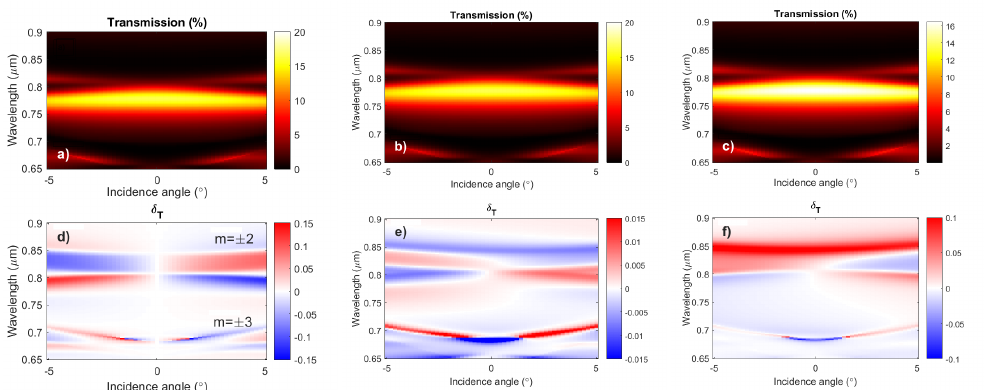
Figure 3. Angular and wavelength-resolved transmission ( a – c ) δ T ( d – f ) spectra of the addressed nanostructure with the uniform spatial distribution of the magnetization in the ferrimagnetic layer (left column), magnetization modulation with λ SW = P (center column), and 2 λ SW = P (right column). The orders of the SPP modes in the left column are denoted by m . The phase shift between the plasmonic grating and the magnetization modulation is